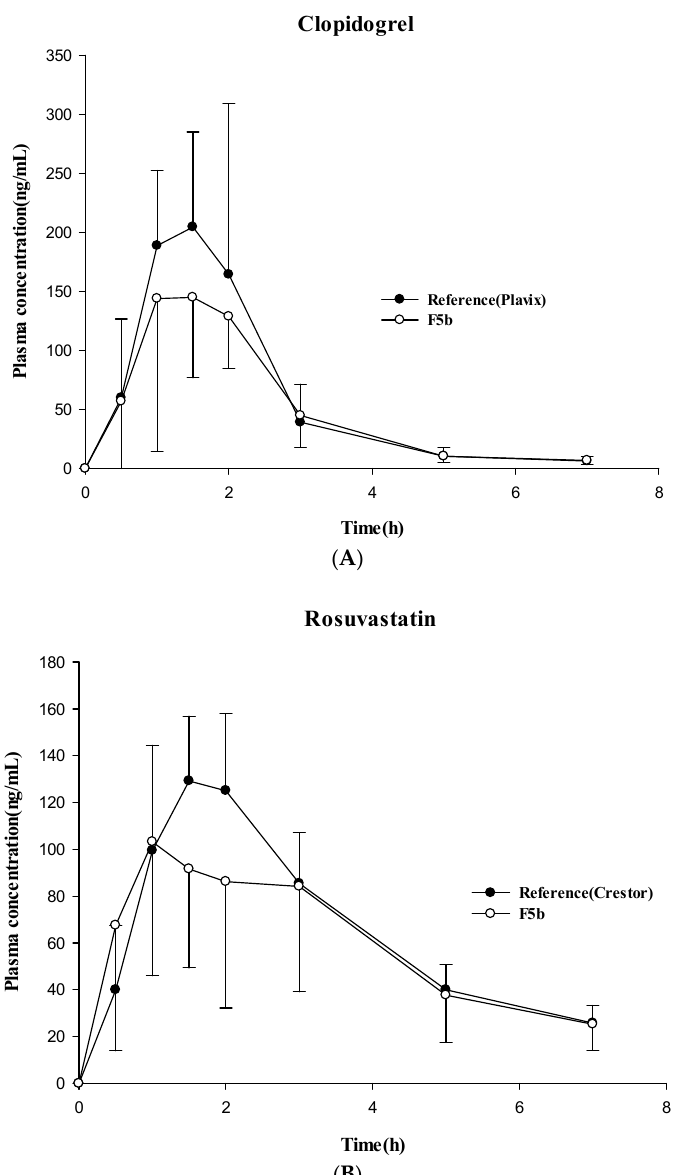
Figure 8. Plasma concentration-time profiles of clopidogrel (150 mg) ( A ) and rosuvastatin (20 mg) ( B ) after oral administration of two different formulations (reference and test) in dogs (mean ± SD, n = 8). Reference: Plavix ® (75 mg) two tablets and Crestor ® (10 mg) two tablets, Test (F5b): two tablets (each containing clopidogrel 75 mg and rosuvastatin 10 mg).